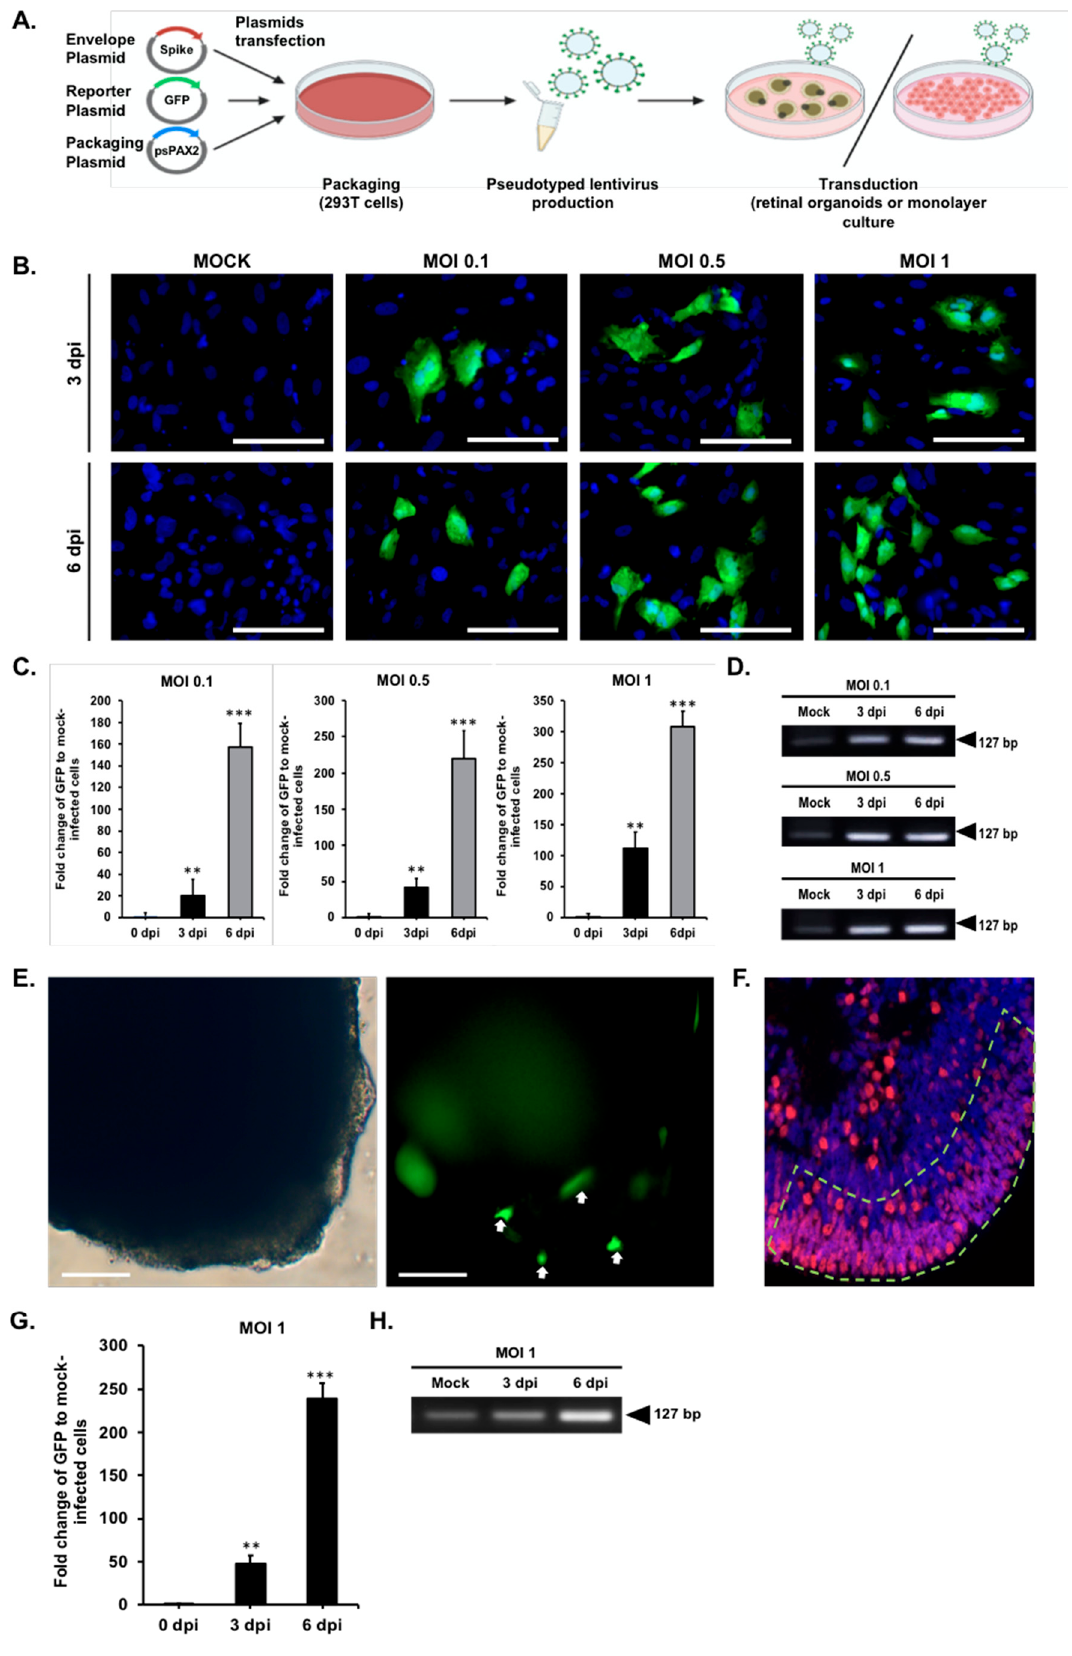
Figure 3. SARS-CoV-2 pseudovirus infection in retinal organoids and monolayer cultures. ( A ) 293T cells were transfected with a plasmid encoding a lentiviral backbone expressing a GFP fluorescent protein, a plasmid-expressing spike protein, and the other necessary proteins essential for virion formation. The transfected cells produced lentiviral particles with